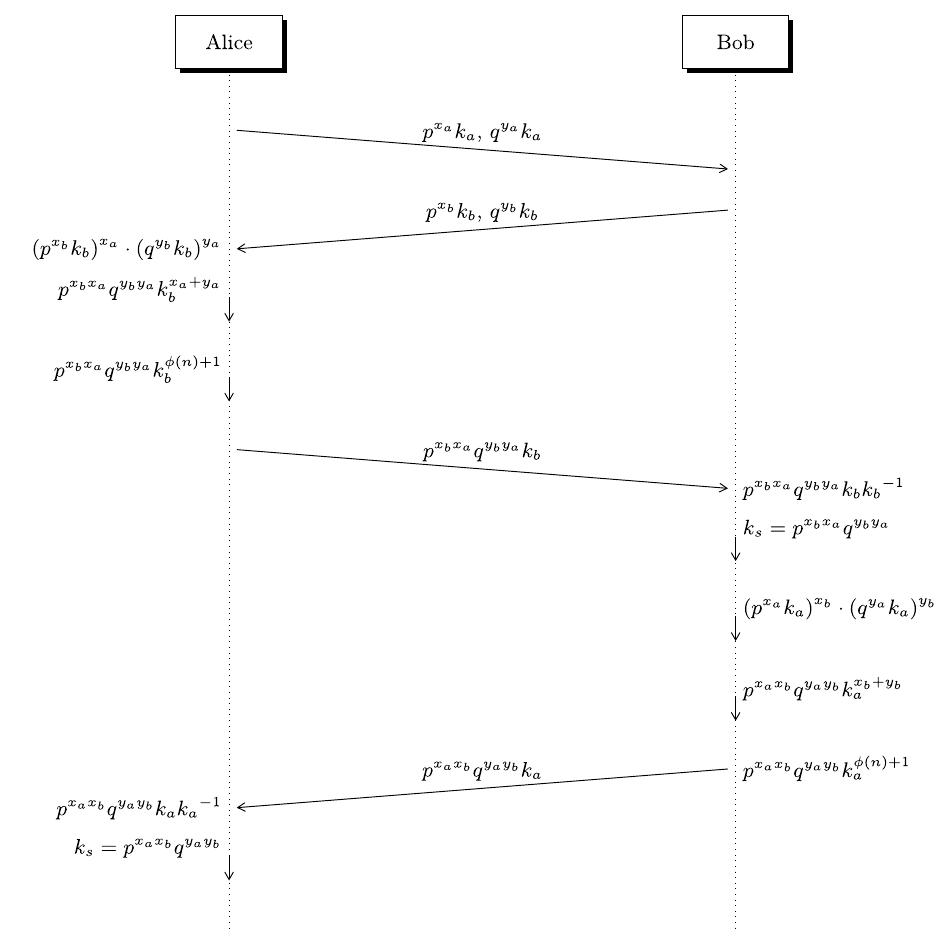
Fig. 3 Non-invertible KEP. All computations in the protocol are performed mod pqr . Here,